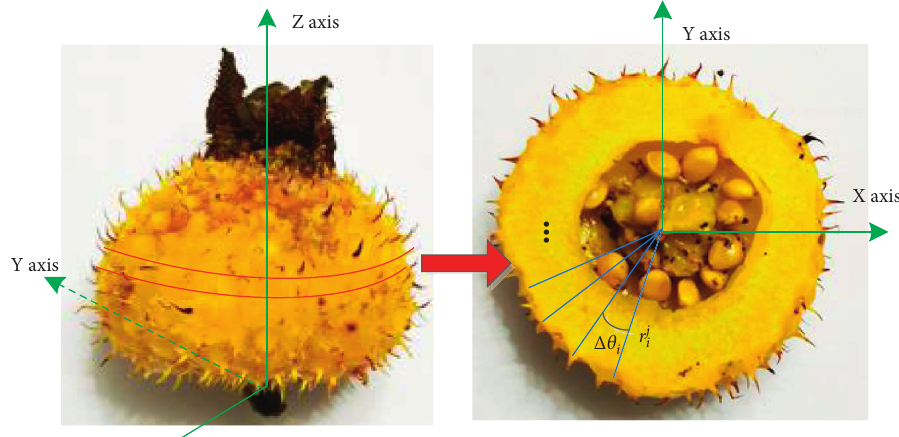
Figure 10: Schematic diagram of calculation of sectional area.